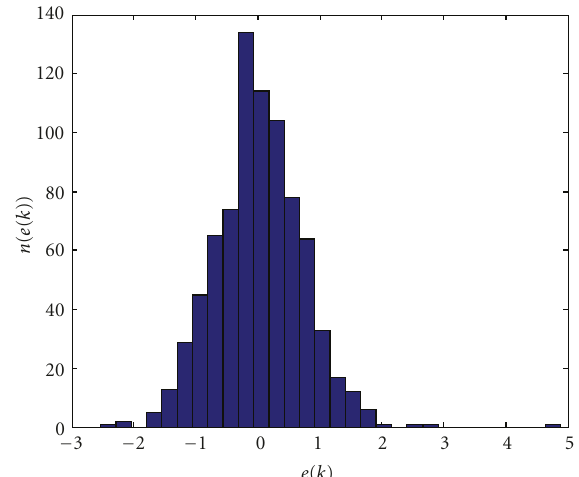
Figure 2: Irregular histogram of equalizer’s output when algorithm fails.